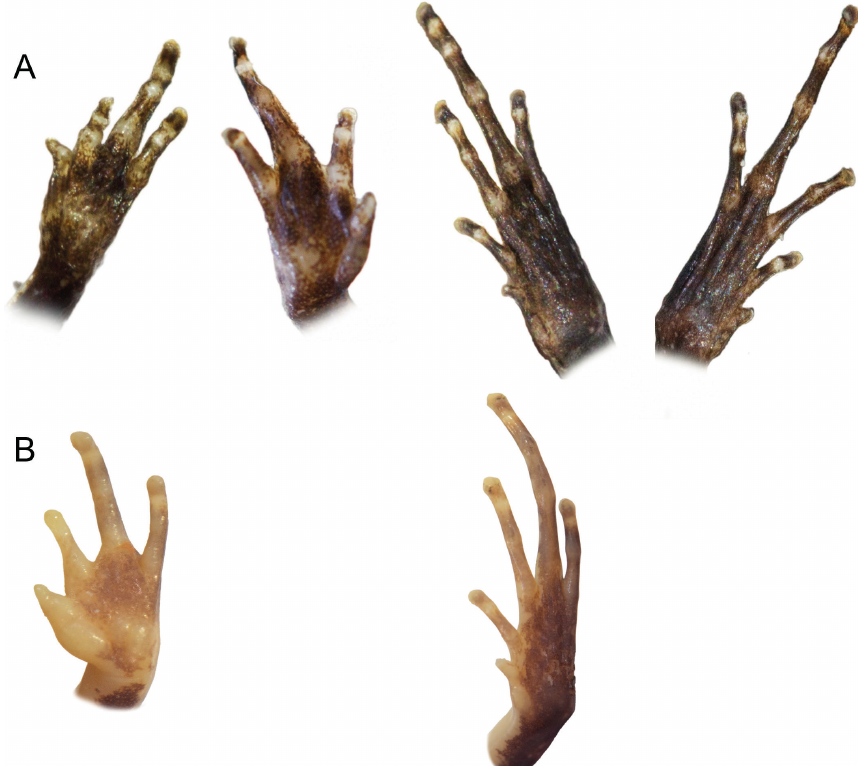
Figure 9. Holotype hands and feet of S. lynnae (row A ) and S. kibomena (row B ). Not to